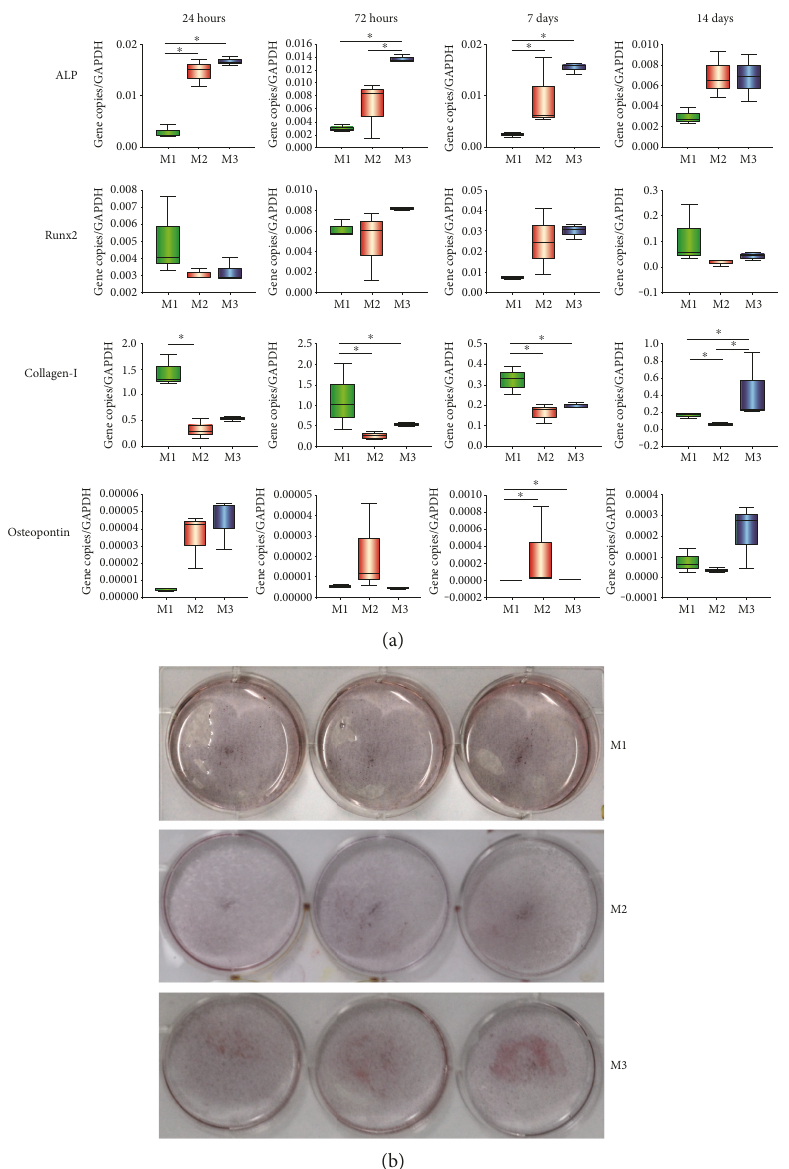
Figure 3: Osteogenic di ff erentiation results of G-MSCs under in fl ammatory environment. (a) The mRNA expression of osteogenic genes (RUNX2, ALP, Col-I, and OPN) in the three groups were measured by real-time PCR at day 1, 3, 7, and 14 days. Expression level was normalized to GAPDH. Signi fi cant di ff erences between groups are marked with an asterisk ( ∗ p < 0 05 ; Dunn ’ s test). (b) Alizarin red staining results of G-MSCs induced by osteogenic inductive medium (M1), in fl ammatory medium (M2), and anti-in fl ammatory treatment medium (M3) after 14 days. GAPDH: glyceraldehyde 3-phosphate dehydrogenase; Runx2: runt-related transcription factor 2; ALP: alkaline